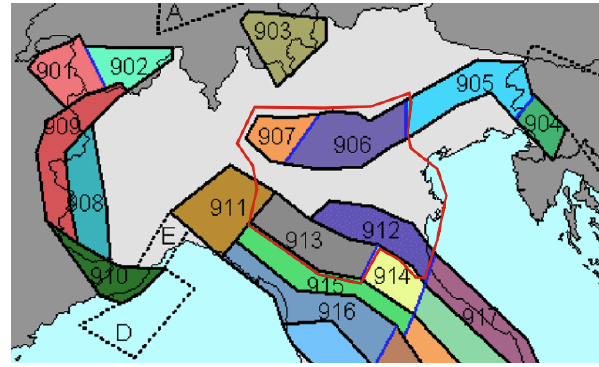
Figure 3. The seismogenic zones whose earthquakes were used for